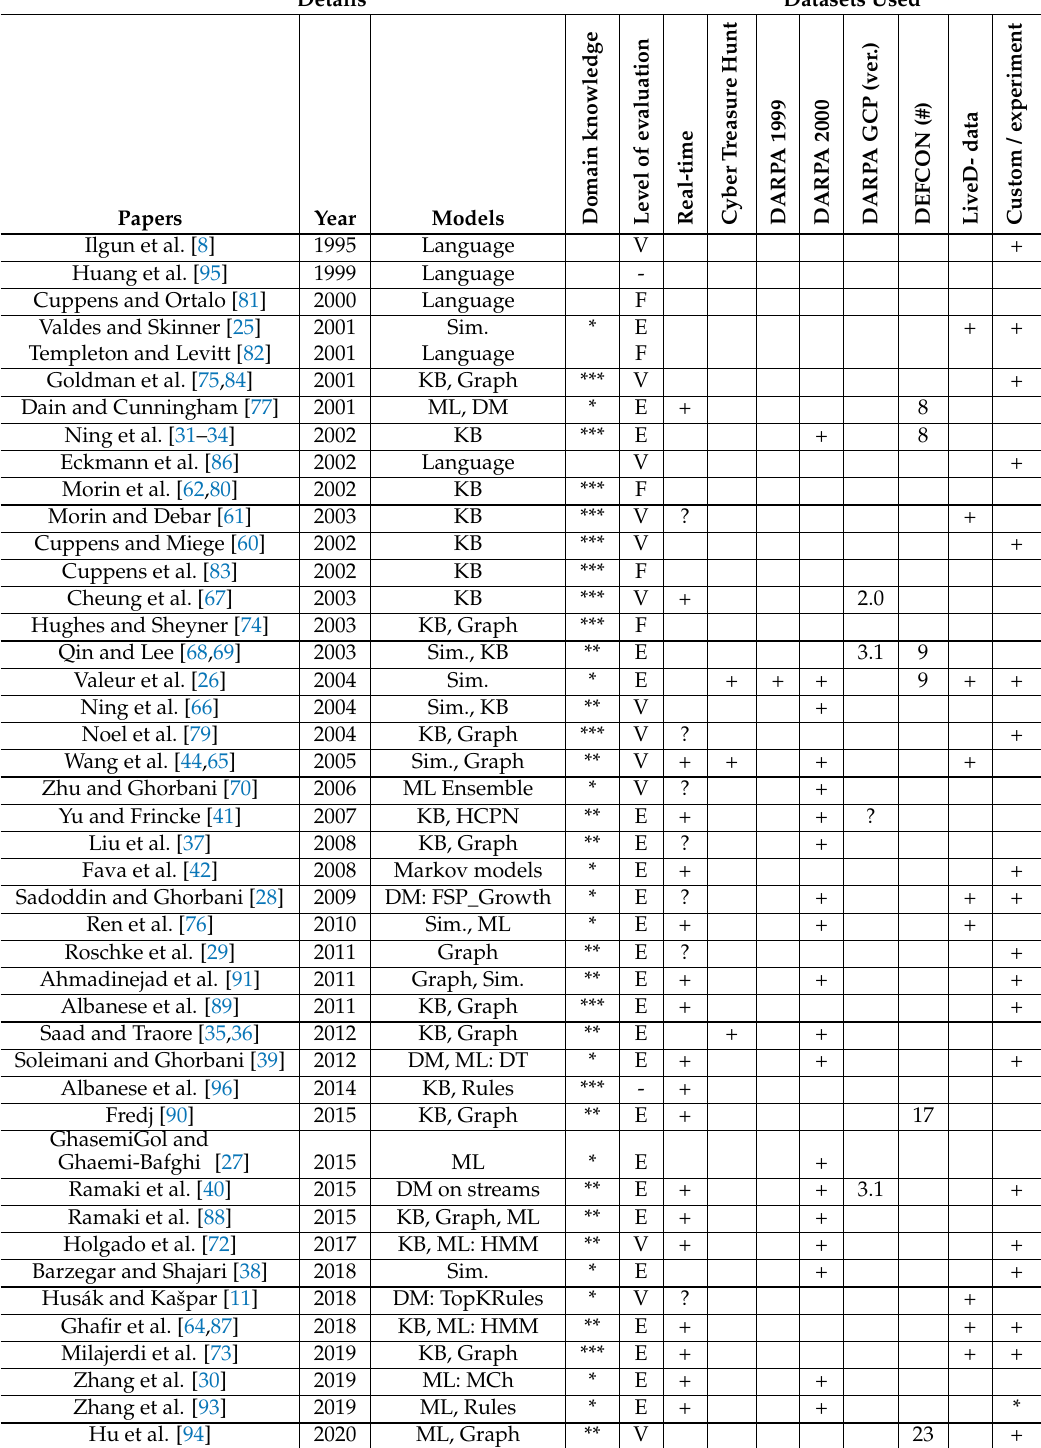
Table 3. Overview of the basic properties and evaluation details of the surveyed